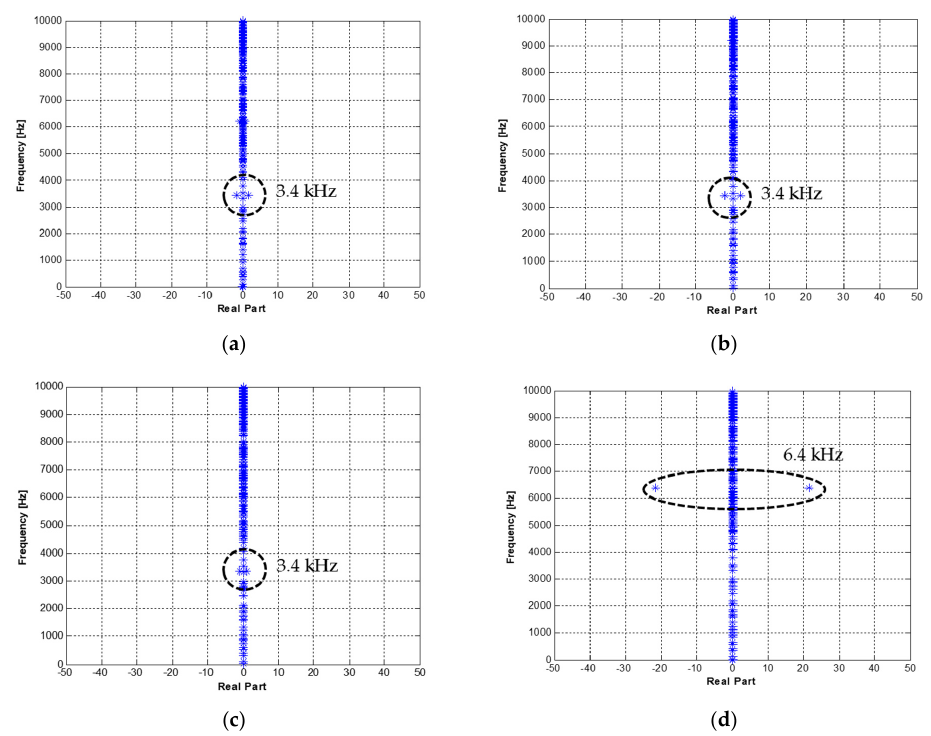
Figure 3. Complex eigenvalue analysis of the assembled brake system model for different brake pressures: ( a ) 10 bar, ( b ) 20 bar, ( c ) 30 bar, and ( d ) 40 bar.